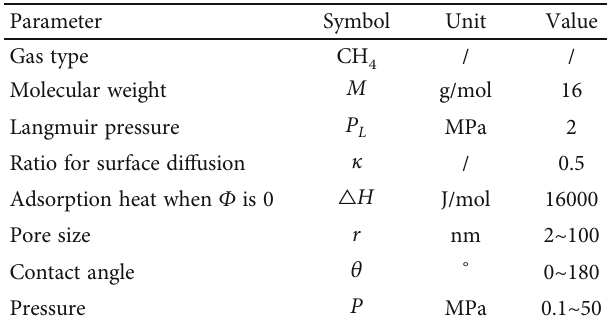
Table 3: The basic parameters for nanocon fi ned gas transport investigation.